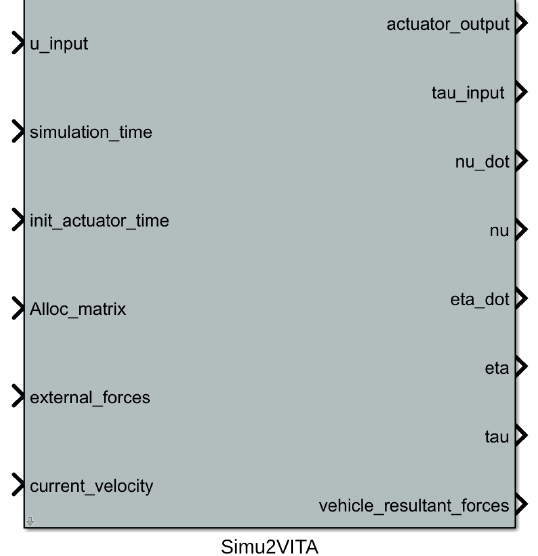
Figure A1. This is how the Simu2VITA block is presented in Simulink.